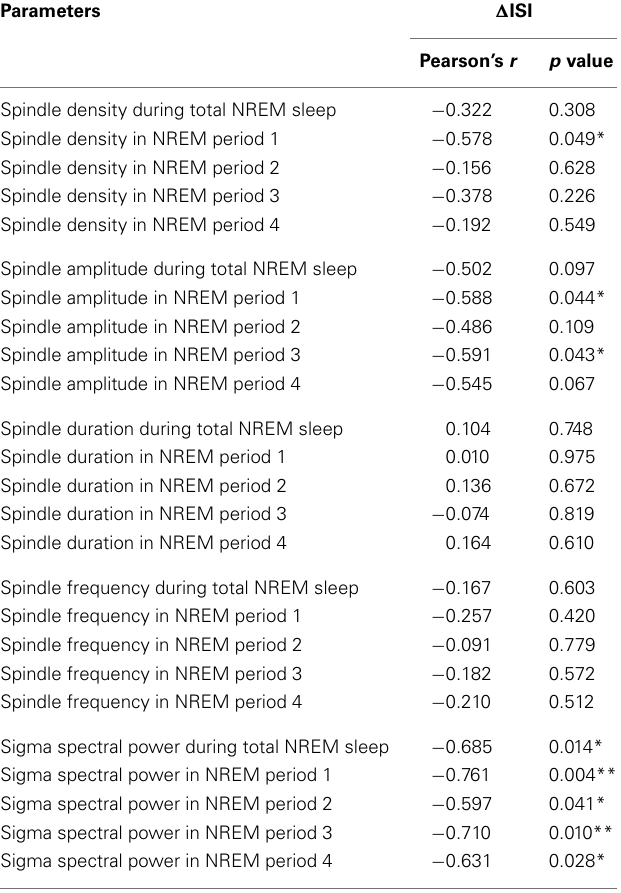
Table 2 | Correlations between baseline spindle parameters or sigma power and change in insomnia severity index from low to high stress period .